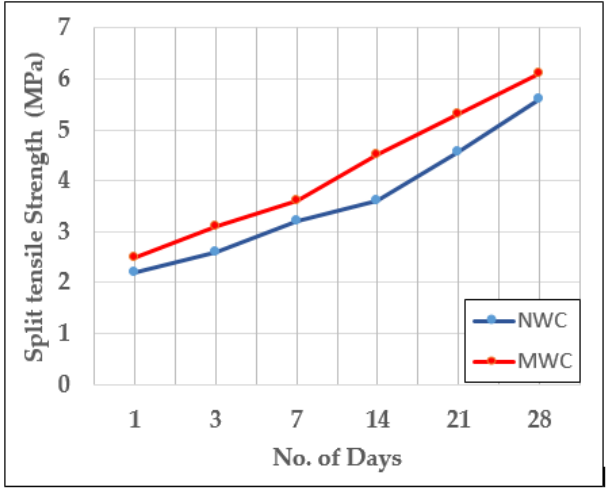
Figure 12. Split tensile strength of concrete (NW with 1% optimized SP Vs MW with 0% SP).